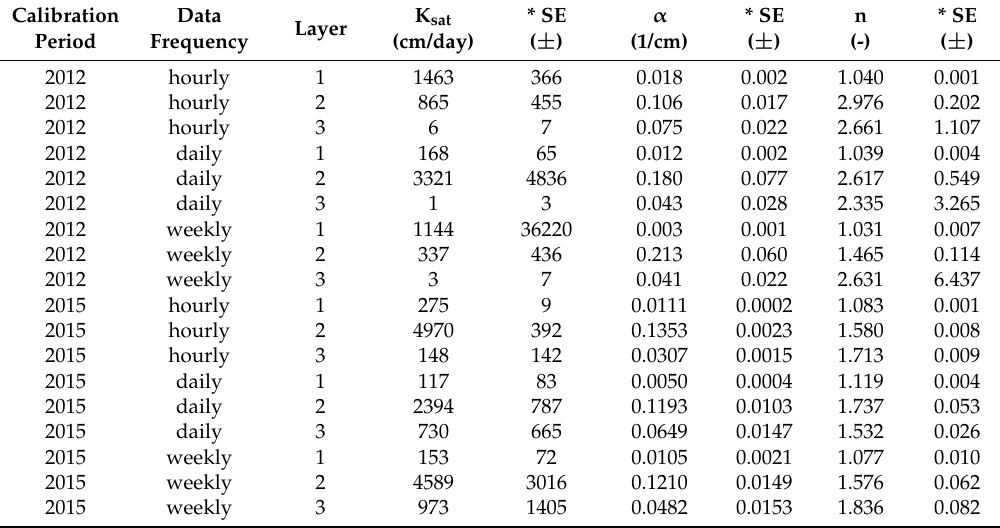
Table 3. Optimized parameters using hourly, daily, and weekly pressure head data. Data are selected from two periods: from June to September 2012 and from April to December 2015. The adopted values of θ s and θ r are shown in Table